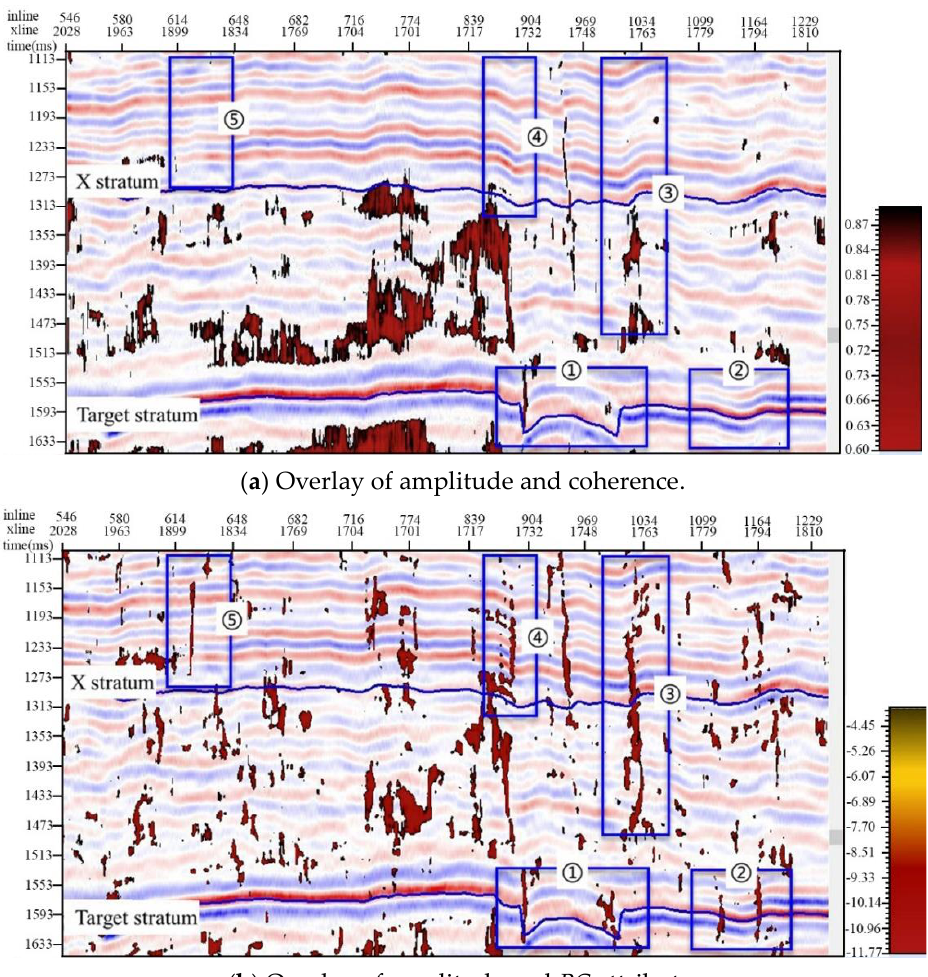
Figure 7. Overlay of amplitude, coherence, and PC attributes. ( a ): amplitude and coherence profile along the redline in Figure 6. ( b ): amplitude and PC profile along the same